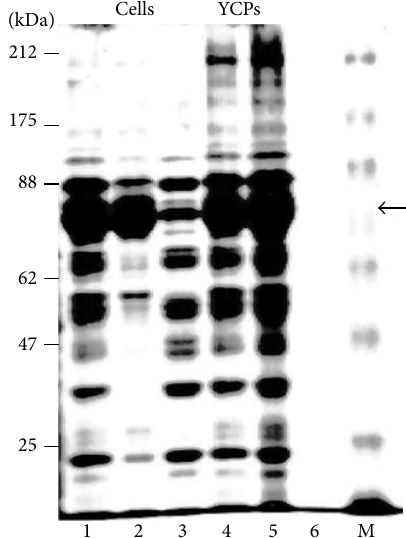
Figure 12: SDS-PAGE of proteins from cells (Lanes 1–3) and YCPs (Lanes 4–6) expressing VP1-GFP (70kDa, arrow, 12% of total protein).Lanes1and4,totalproteins.Lanes2and5,16,000 × gpellet. Lanes 3 and 6, 16,000 × g supernatant. M: marker